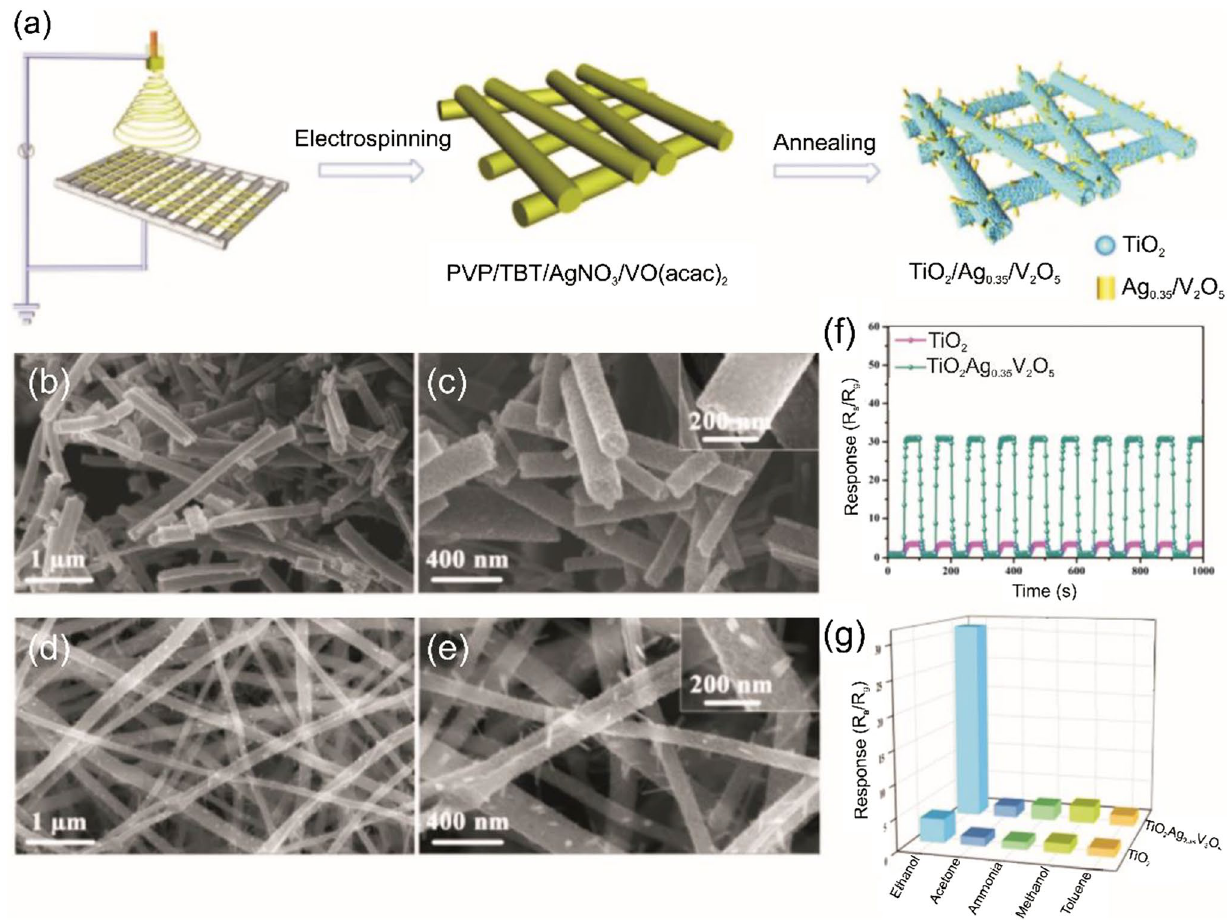
Fig. 5 a Schematic of the fabrication process for the TiO ( b , c ) TiO nanofibers and ( d , e ) TiO 2 Ag V O branched nanoheterostructures sensor that were exposed to 100 ppm of ethanol vapors at 350 °C and ( g ) selective tests to sev- 0.35 2 5 eral gases. Images reproduced from [85] with permission of Springer